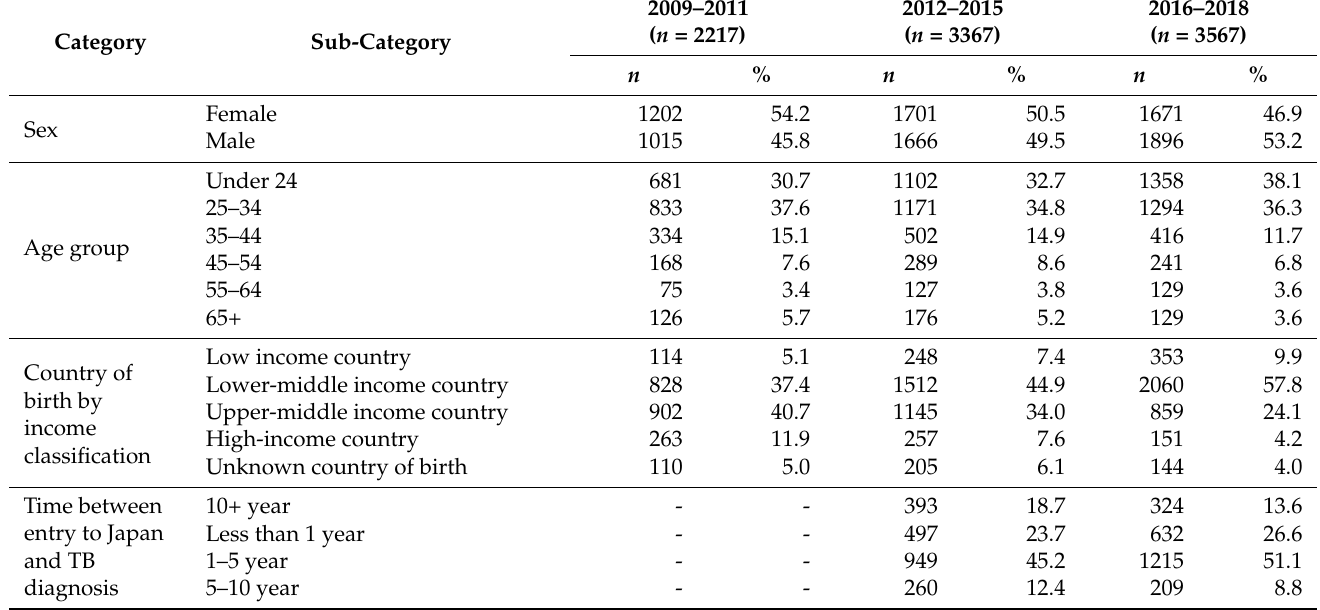
Table 2. Characteristics of overseas-born patients with pulmonary tuberculosis by year